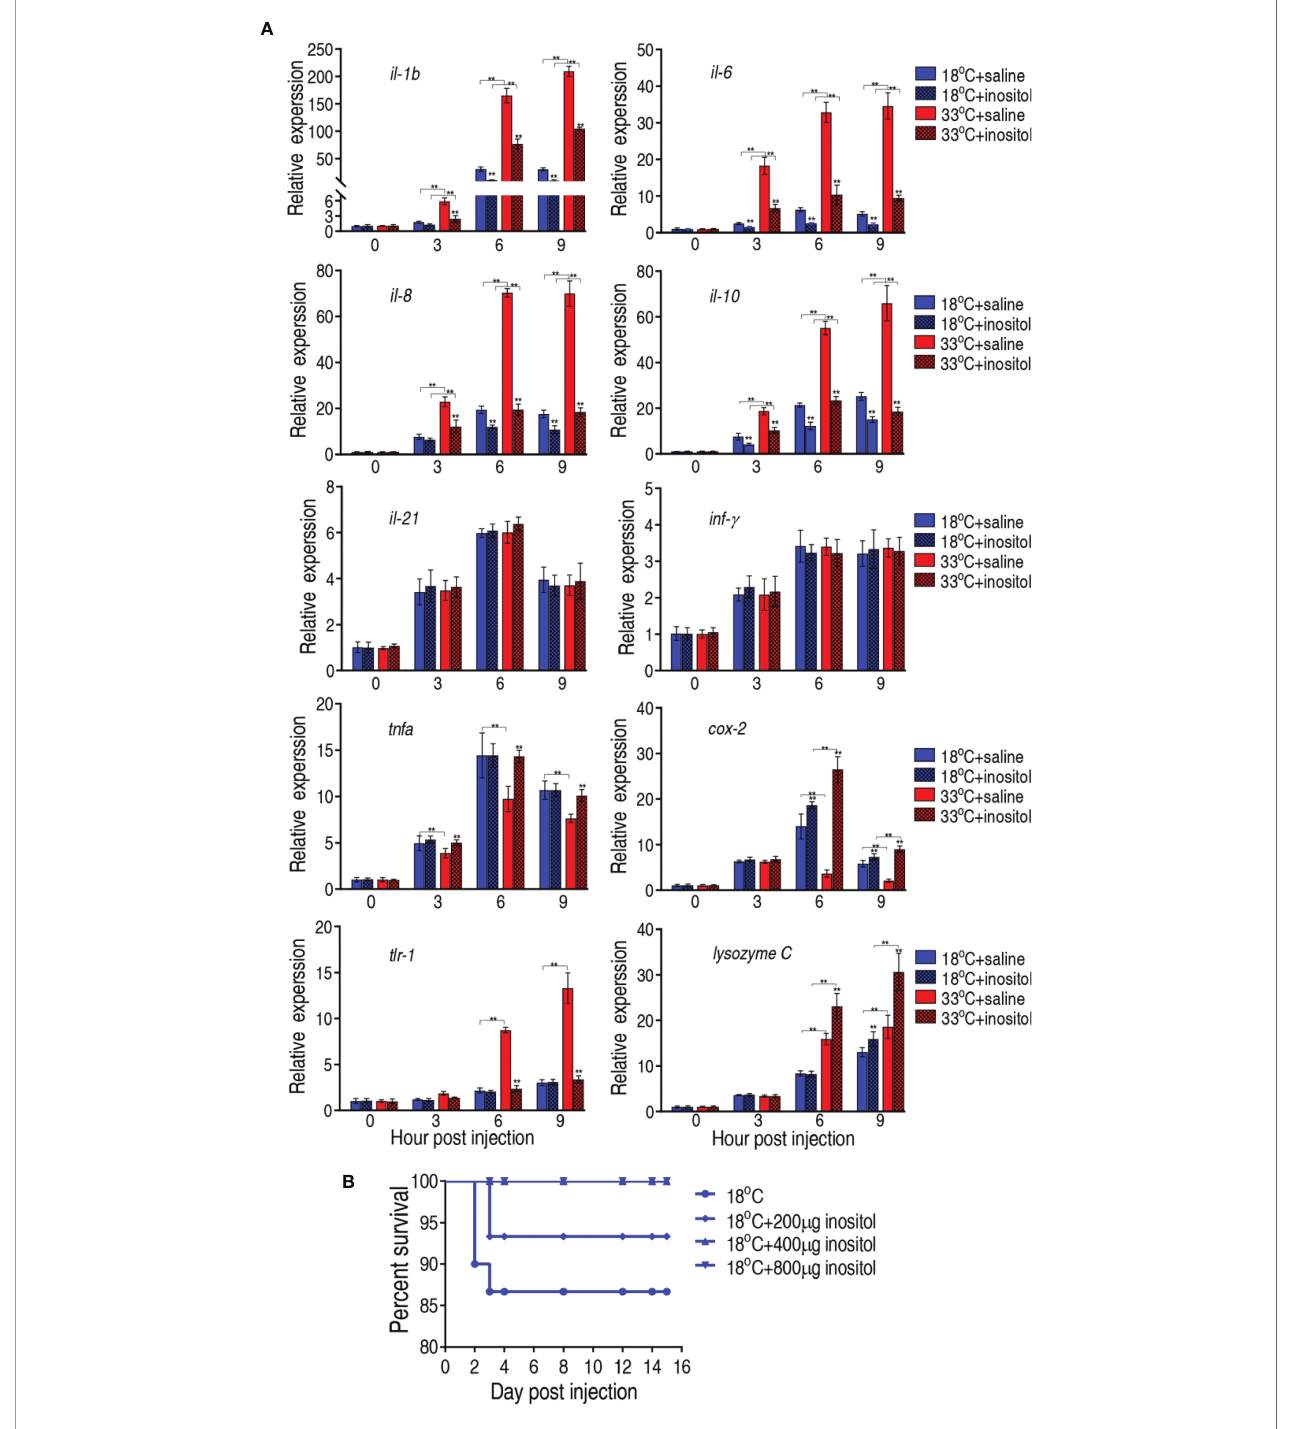
FIGURE 8 | Innate immune responses of tilapias. (A) qRT-PCR for innate immune genes of tilapia treated with saline solution (control) or 800 µg myo -inositol for 3 days following A. sobria challenge through intraperitoneal injection (1 × 10 3 CFU A. sobria ). Spleens were collected at 0, 3, 6, and 9 h postinjection for RNA extraction and qRT-PCR. Values are means ± SEM from six biological replicates. **p < 0.01. (B) Survival of tilapias post A. sobria infection in the presence of myo -inositol. Tilapias were treated with saline control (0 µg per fi sh) or different doses of myo -inositol (200, 400, and 800 µg per fi sh) at 18°C for 3 days, followed by bacterial challenge through intraperitoneal injection (1 × 10 5 CFU A. sobria ). The accumulative fi sh death was monitored for a total of 15 days postinfection (n =30 per